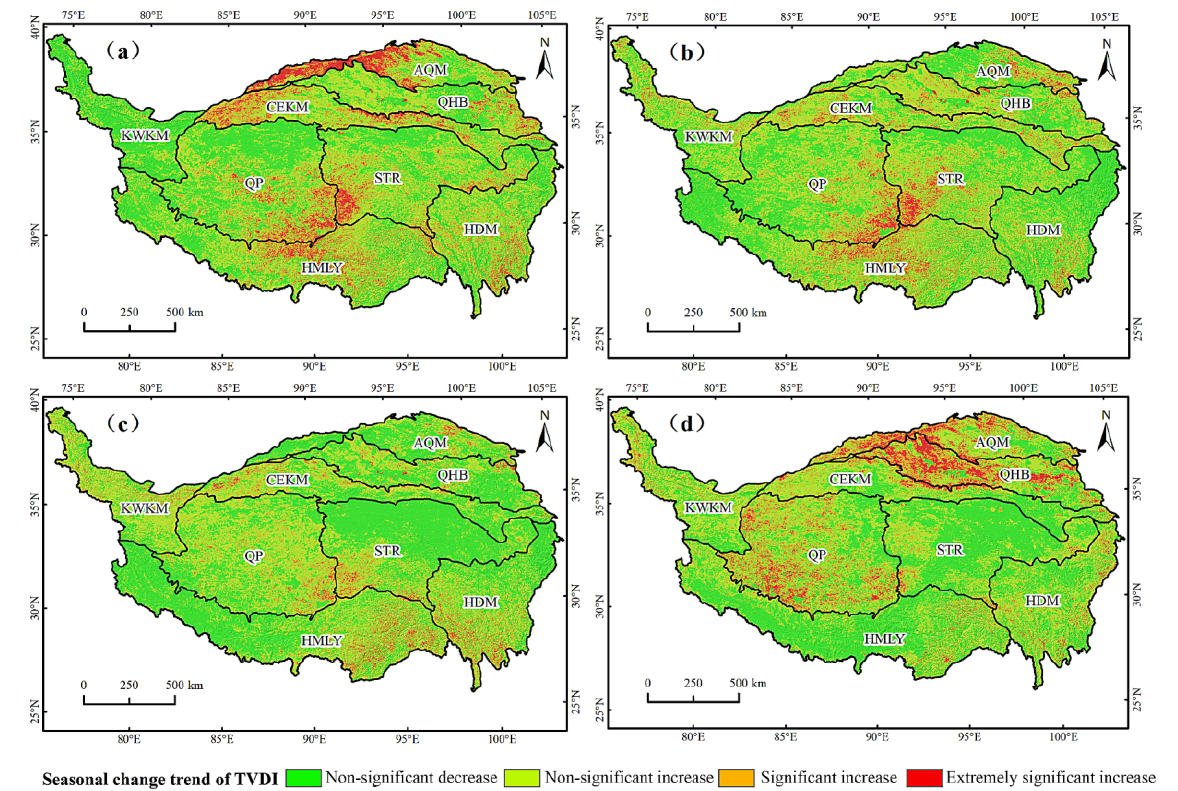
Figure 9. Seasonal trend in TVDI for the QTP. ( a ) spring; ( b ) summer; ( c ) autumn; ( d ) winter. Figure 9. Seasonal TVDI trends of the QTP. ( a ) Spring; ( b ) summer; ( c ) autumn; ( d ) winter.